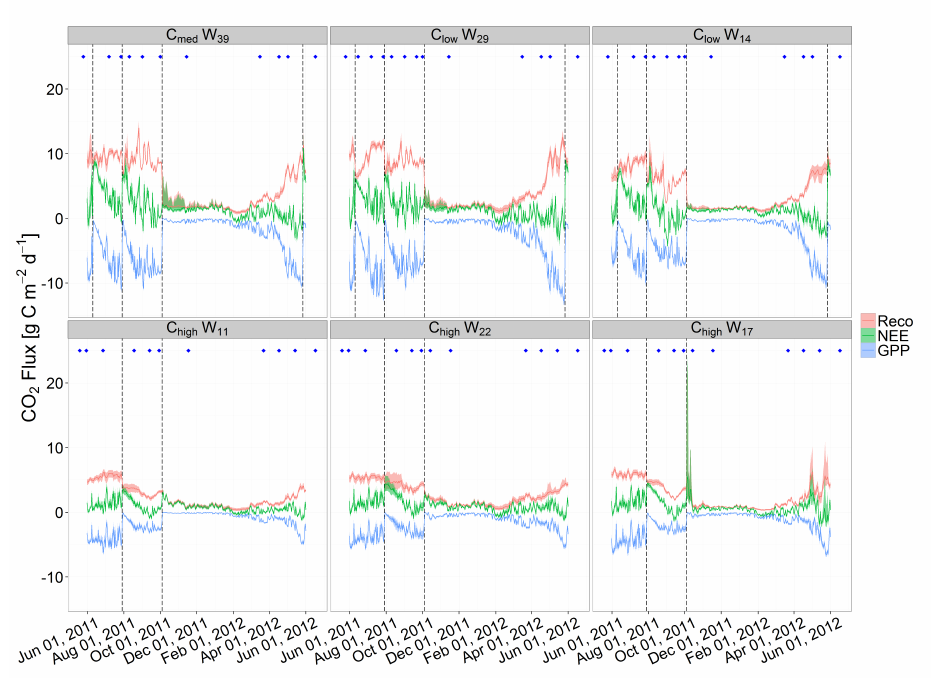
Fig. 2. Time series of daily CO 2 fluxes [gCm − 2 d − 1 ] at each site (1 June 2011–1 June 2012). Depicted are modelled fluxes and 95% confidence band. Dashed lines indicate grazing and mulching events. Diamonds indicate measurement